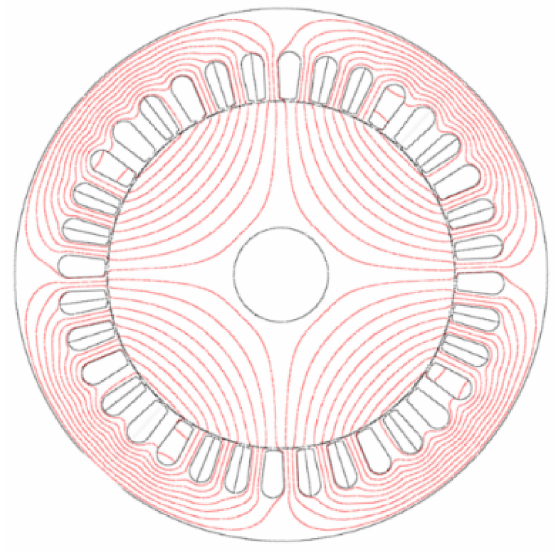
Figure 4. Magnetic flux flowing through the core.